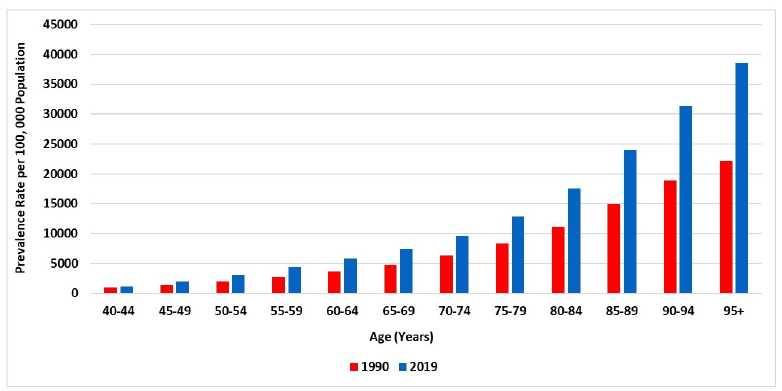
Fig 2. The prevalence rate of COPD in Saudi Arabia (1990 and 2019), stratified by age.